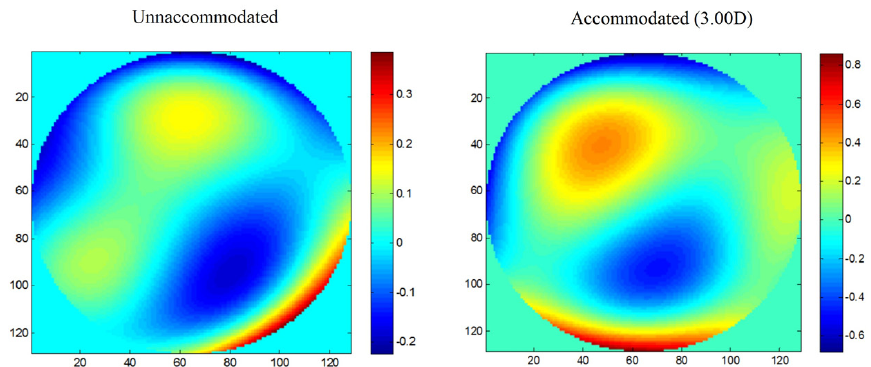
Figure 3. Wavefront maps of the anterior surface of the crystalline lens unaccommodated and accommodating 3.00D. Adapted with permission from Ref. [11] “Simultaneously measuring ocular aberration and anterior segment biometry during accommodation” by Y. Wang, Y. Shao and Y. Yuan, 2015, Journal of Innovative Optical Health Sciences , Volume 8(2), 1550005-3, Copyright @2015, World Scientific. (https://doi.org/10.1142/S1793545815500054).